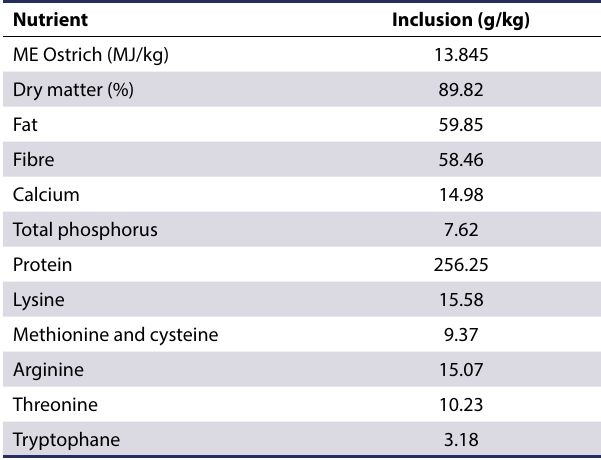
Table Ib: Nutritional composition of pre-starter diet (Brand 2005) fed to chicks during Trial